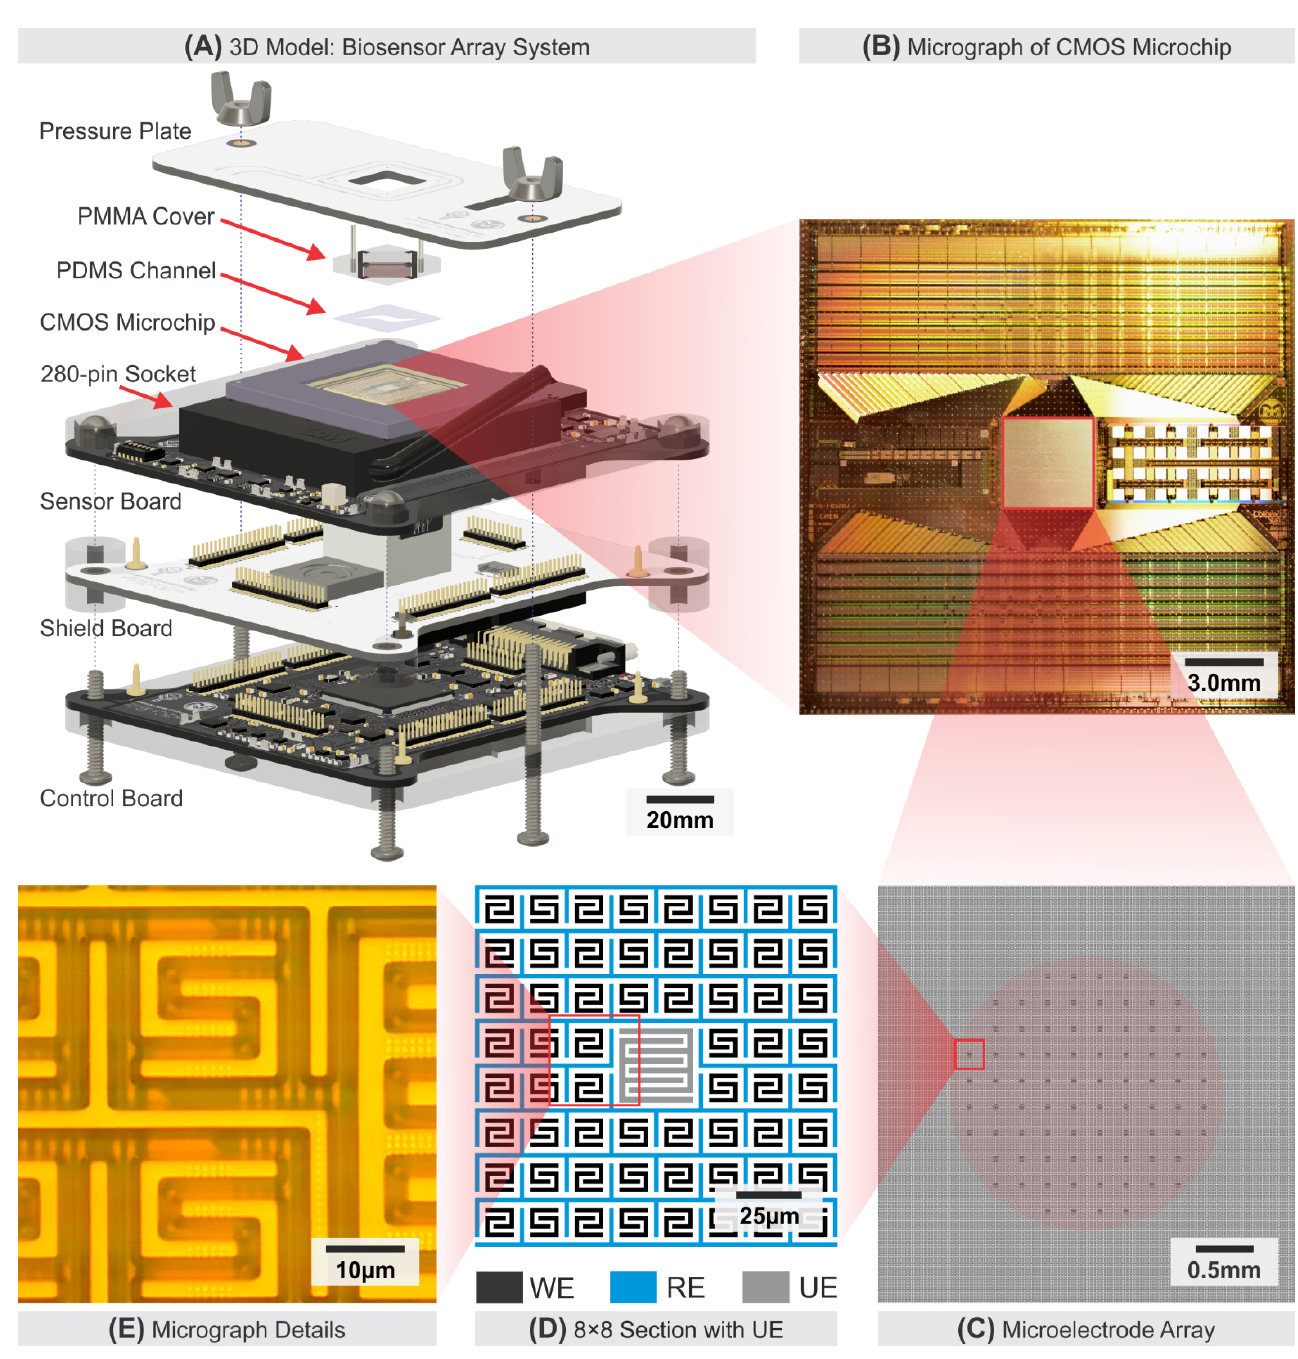
Figure 1. Electrochemical sensor system overview. ( A ) Sensor system 3D model assembly of the CMOS microchip, support PCBs, and microfluidic system arrangement. ( B ) CMOS microchip with MEA micrograph, showing an array of read channel circuits and the 3.6 mm × 3.6 mm MEA. ( C ) The MEA consists of 16,064 WE, an interleaved RE, and 80 pairs of interdigitated UEs around the center of the MEA. ( D ) An 8 × 8 subsection of the MEA showing configurations of the WE, RE, and UE. ( E ) A detailed micrograph of the surface electrode.